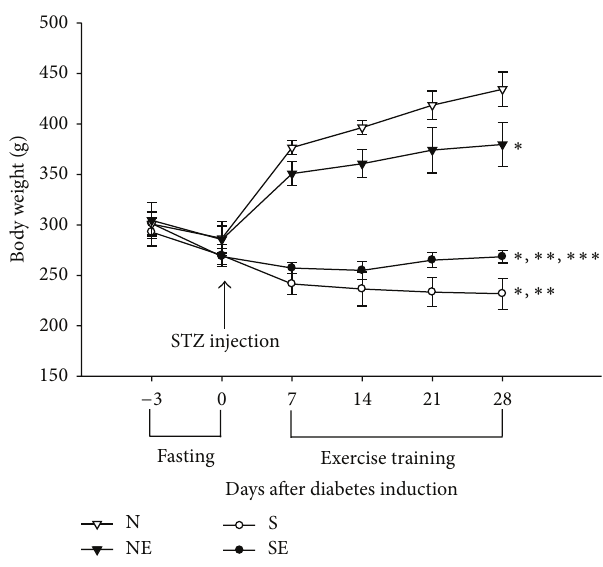
Figure 1: The changes of rats’ body weight after STZ injection and 3-week exercise training. N: nondiabetic rats; NE: nondiabetic rats with exercise; S: STZ-induced diabetic rats; SE: STZ-induced diabetic rats with exercise ( 𝑛 = 8 per group). ∗ 𝑃 < 0.05 , compared withtheNgroup; ∗∗ 𝑃 < 0.05 ,comparedwithNEgroup,and ∗∗∗ 𝑃 < 0.05 , compared with the S group; (one-way repeat measurement